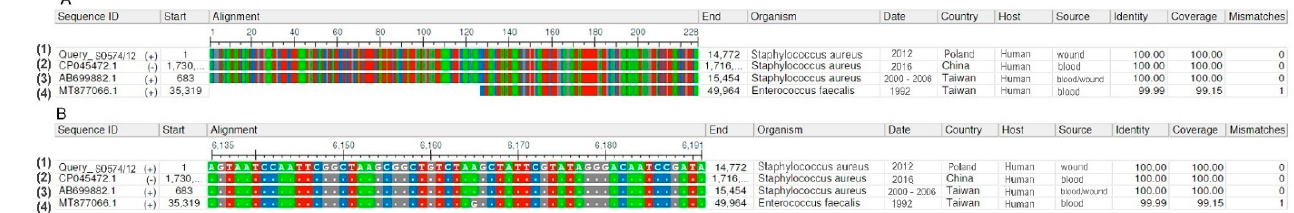
Figure 5. Multiple sequence alignment of erm B containing genomic regions (partial visualization of aligned sequences) of four strains: ( 1 ) MES PM1-like of CA-MRSA SO574/12 SCC mec Vb/ST338/CC59 clinical isolate; ( 2 ) MES PM1-like of CA-MRSA ZY05 SCC mec Vb/ST338/CC59 reference Taiwan